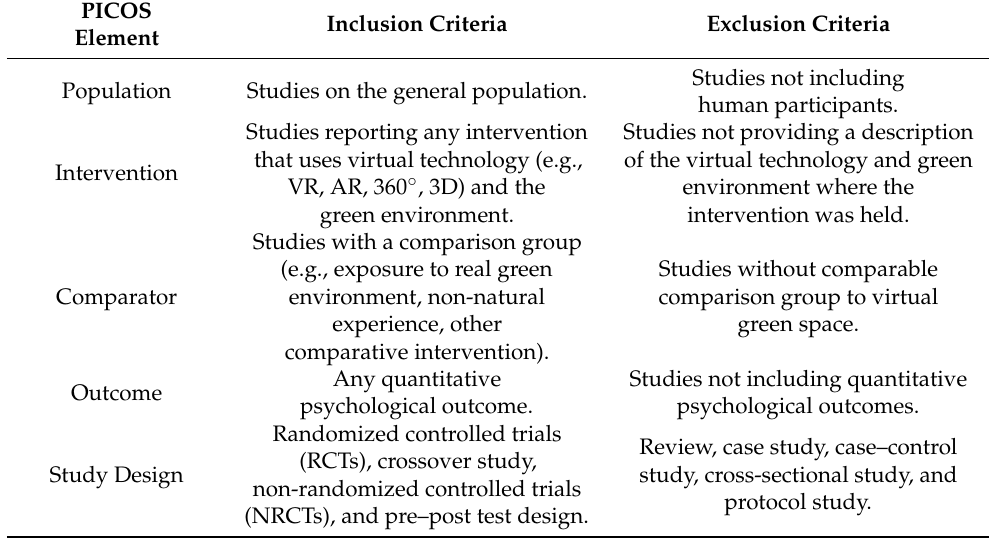
Table 1. Eligibility criteria for study